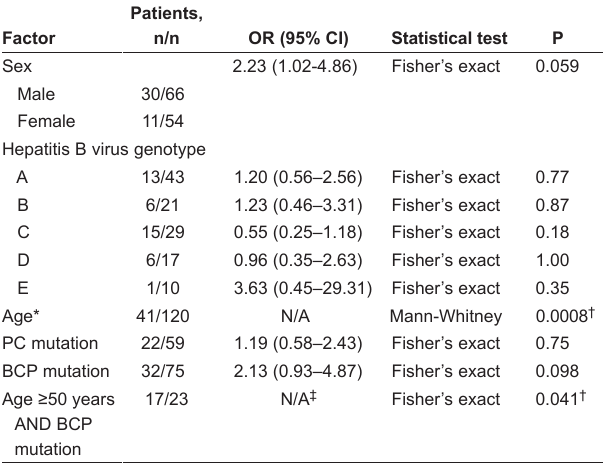
TaBle 3 Factors associated with abnormal liver imaging